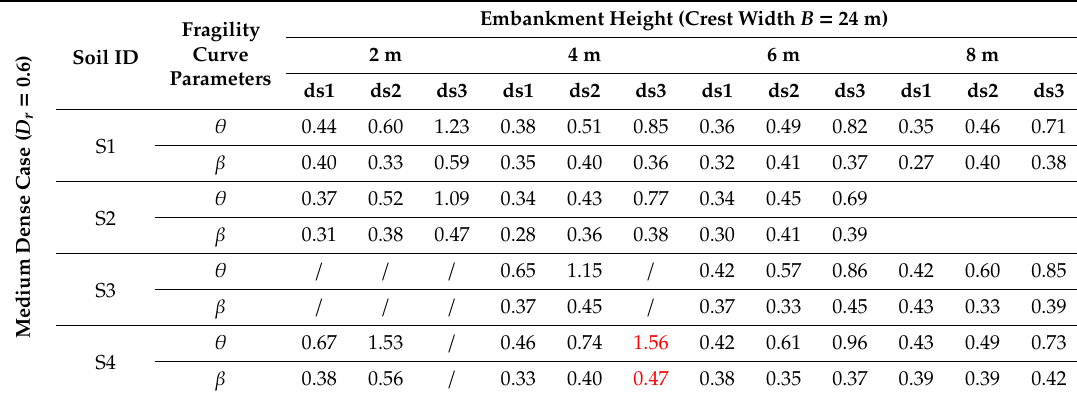
Table 8. FC parameters for di ff erent embankment heights (medium dense soil, PGA, railway